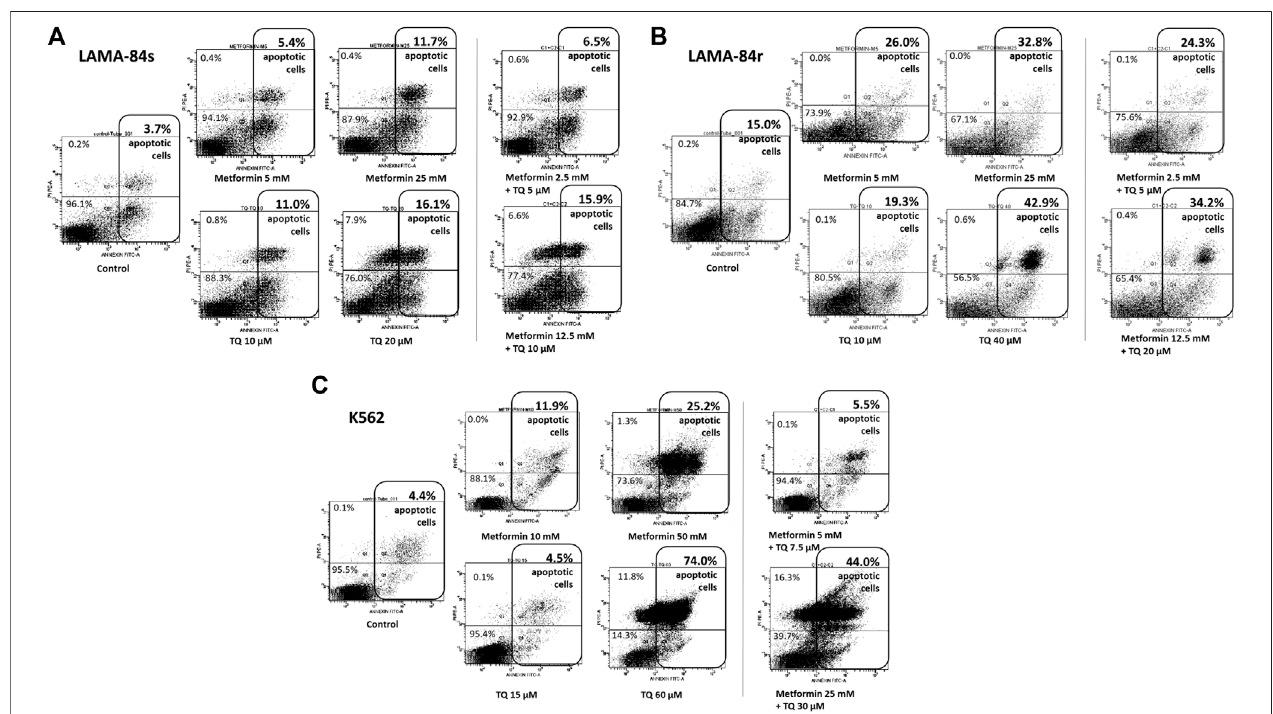
FIGURE 3 | Flow cytometry Annexin V/PI analysis was used to determine the percentage of cells in apoptosis after metformin and thymoquinone (TQ) monotherapies and combinatorial treatments for 48 h in (A) LAMA-84s, (B) LAMA-84r, and (C) K562 cell lines.